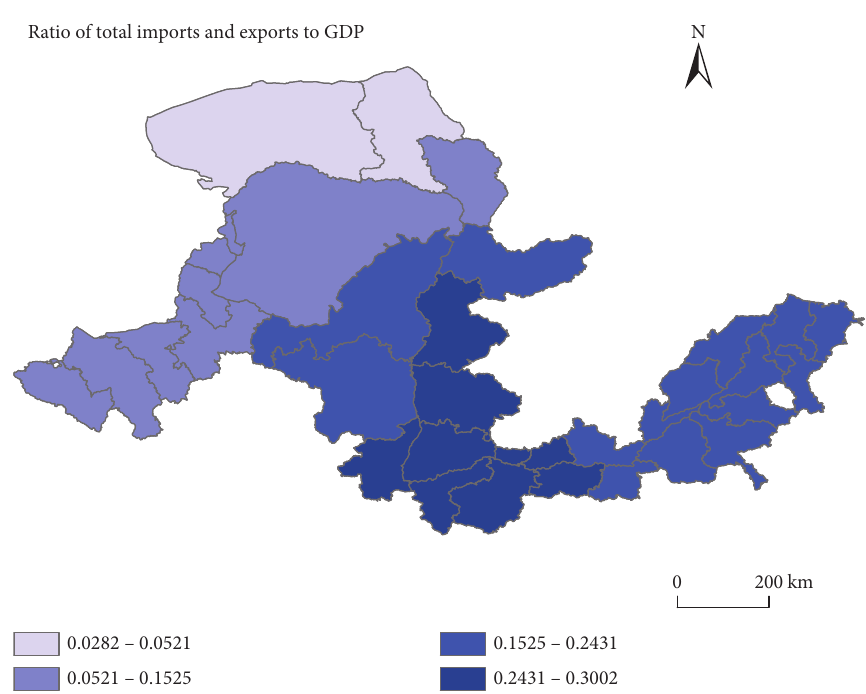
Figure 7: Spatial distribution of regression coefficient of total imports and exports to GDP on